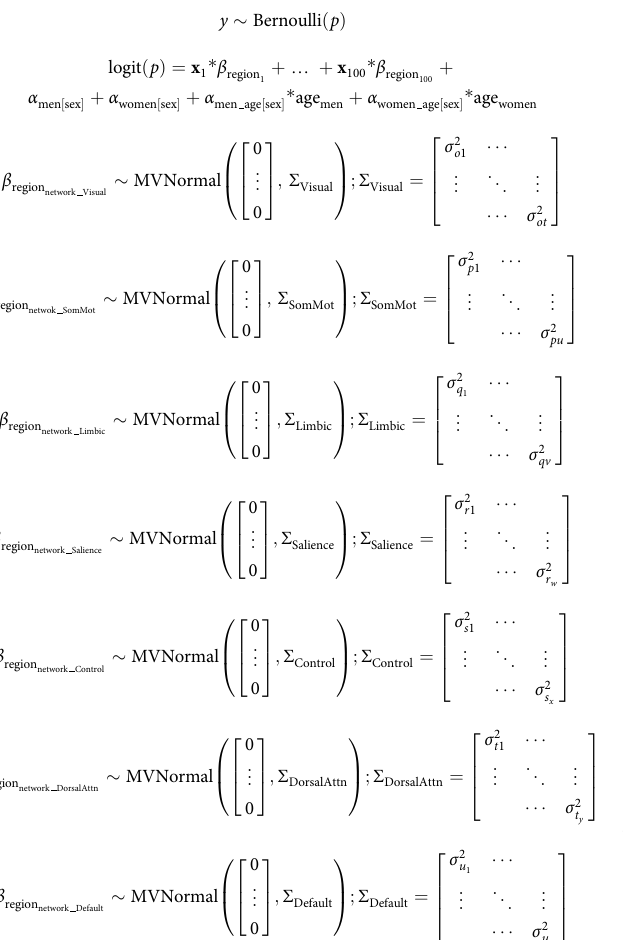
The fi rst model speci fi cation was tailored to careful inference of the posterior distributions of parameters at the brain region level to explain possible divergence between lonely and non-lonely individuals (model equation